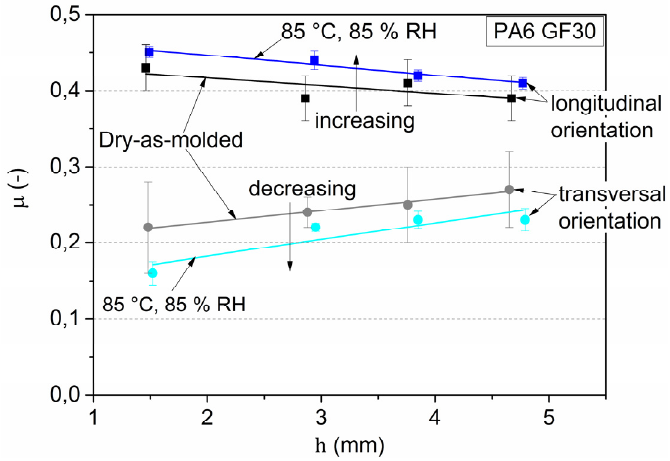
Figure 8. Change of Poisson’s ratio depending on sample thickness, longitudinal and transverse orientation after climate storage of 1000 h in 85 °C and 85% RH.